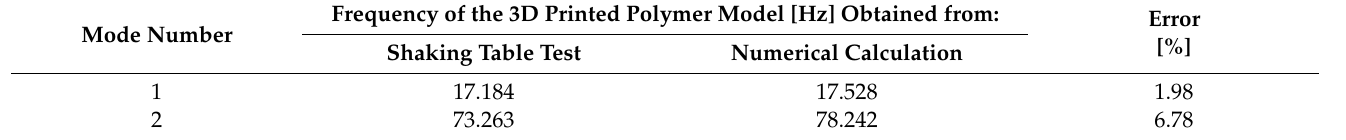
Table 8. The comparison of the natural frequencies of the 3D printed polymer model obtained from the shaking table test and the numerical